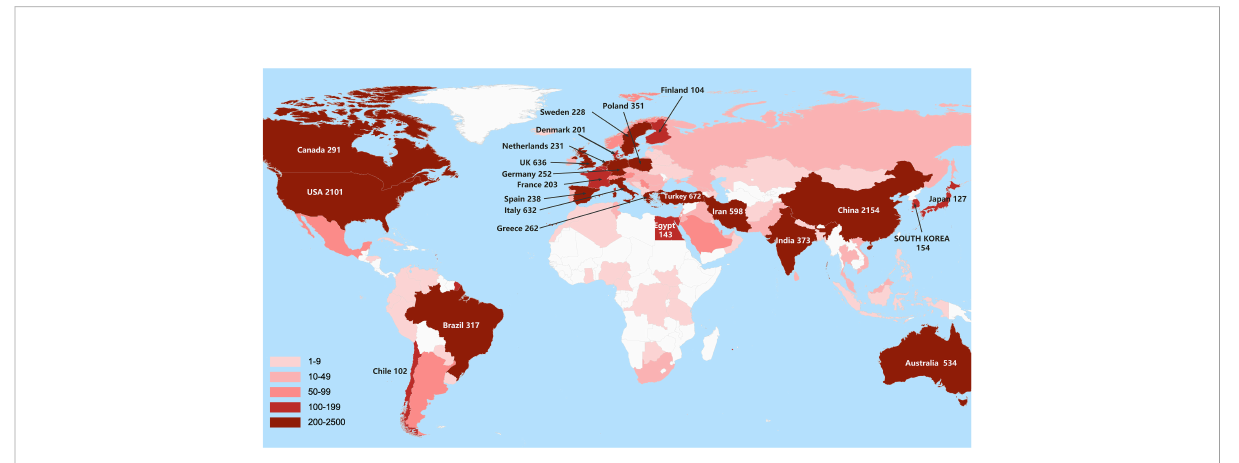
FIGURE 2 A world map displaying the contribution of each country to PCOS research based on publication counts: the darker the color, the more publications, as shown at the bottom